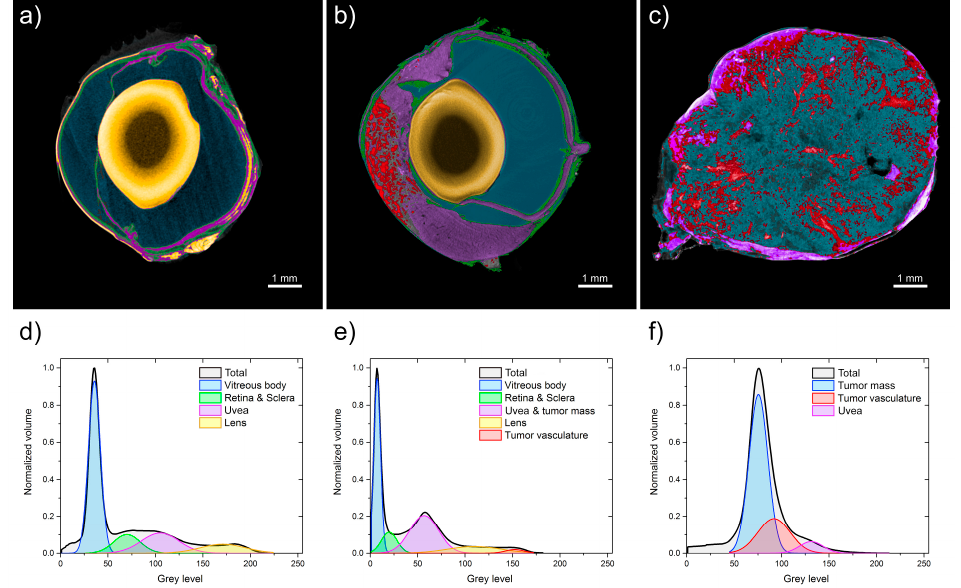
Figure 3. Analysis of micro-CT images. Volume-rendered 3D image of ( a ) a normal hamster eyeball and with melanoma at different stages, ( b ) medium-sized tumor, and ( c ) large tumor. Gray-value histograms based on the micro-CT images of a hamster eyeball stained in Lugol solution for 96 h: ( d ) control group, and ( e ) eyeball with medium melanoma and ( f ) large melanoma. The fitted Gauss curves correspond to the main anatomical parts of the samples, i.e., vitreous body, retina, and sclera; choroid, lens, tumor vasculature, and tumor mass.